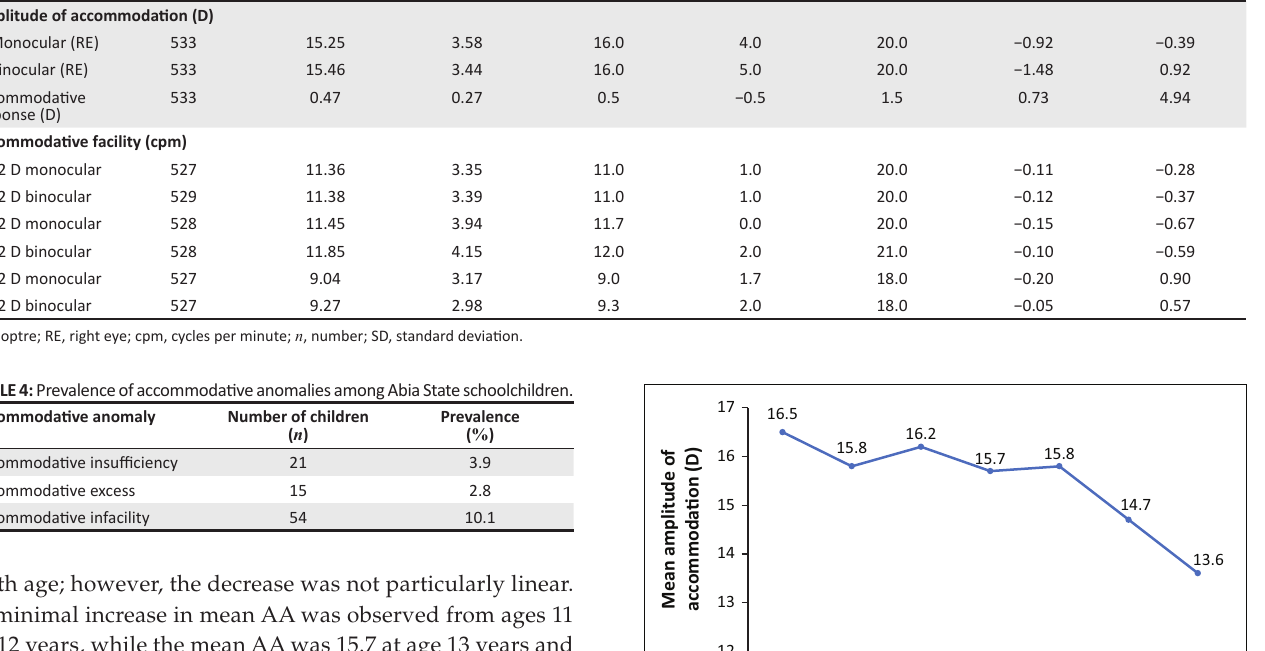
TABLE 3: Descriptive analysis of overall accommodative findings of schoolchildren in Abia State. Variables n Mean SD Median Minimum